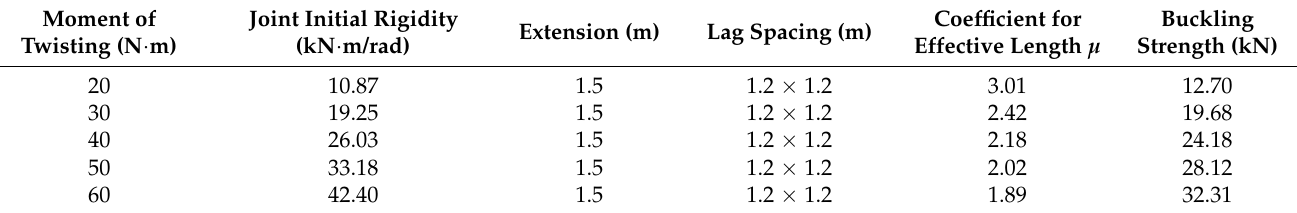
Table 4. Stable bearing capacity of vertical rod under fastener rotational stiffness.